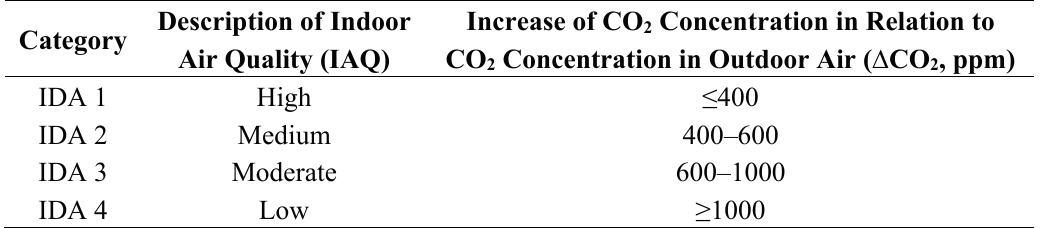
Table 2. Classification of IAQ according to PN-EN 13779